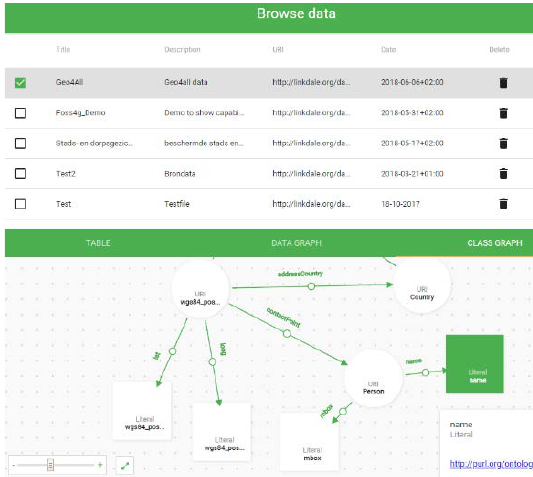
Figure 5. The view of the Browse Data